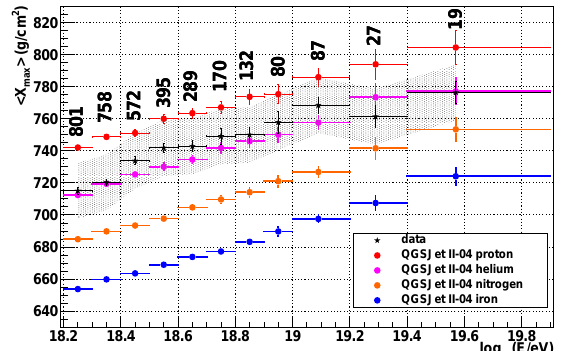
Figure 4: TA BR / LR hybrid (cid:104) X max (cid:105) compared to system- atic uncertainty of the QGSJET II-04 model predictions for proton and helium primary sources. Model systemat- ics are estimated from